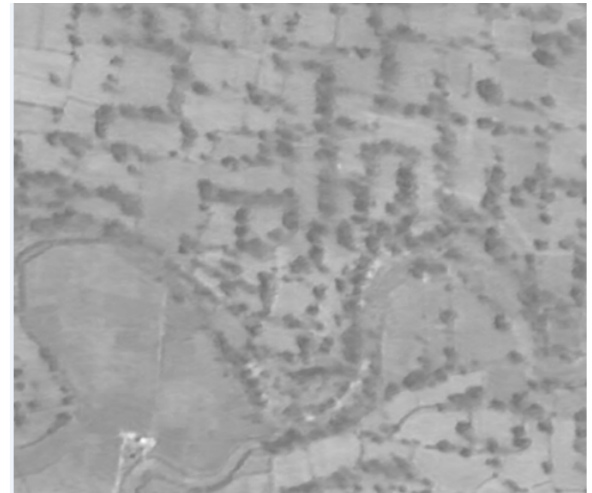
Figure 2. Sample panchromatic image